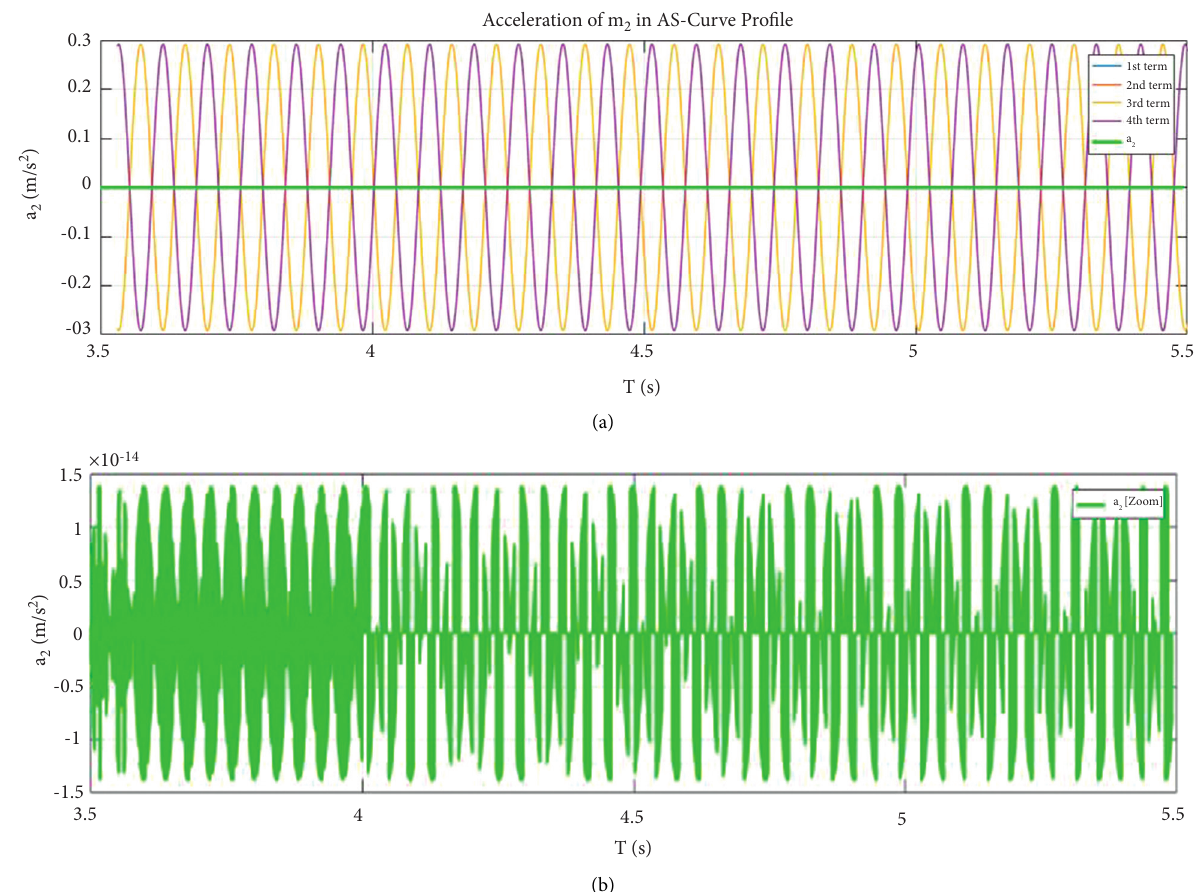
Figure 12: Simulation of the vibration suppression of m term, green: m 2